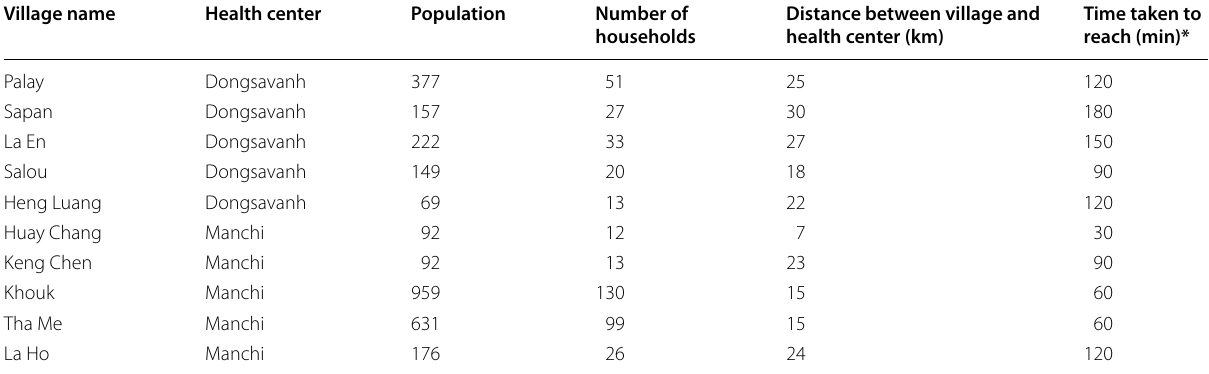
* By motorbike with or without boat